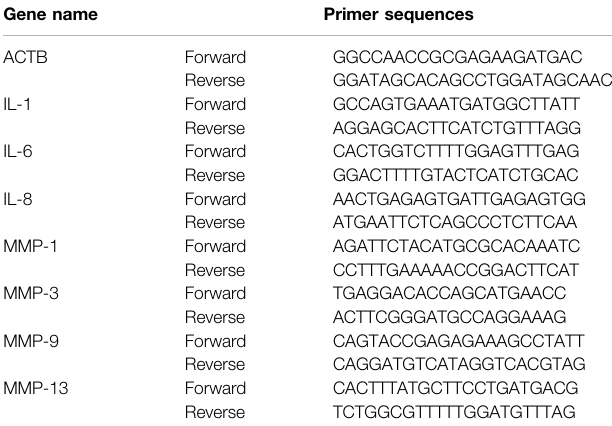
TABLE 1 | Primer sequences for real-time PCR.